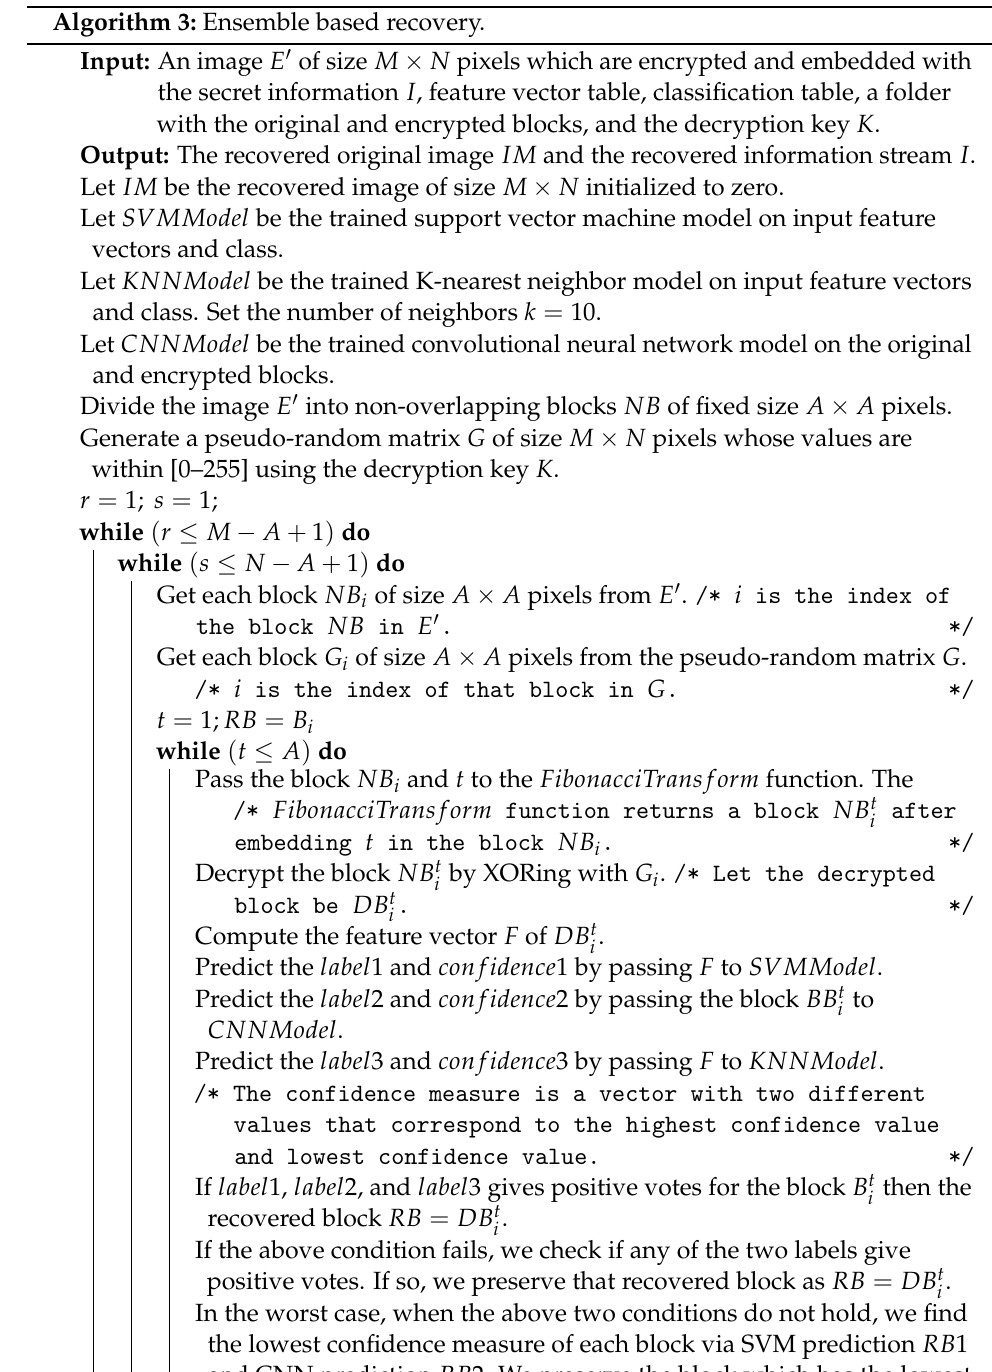
Algorithm 3: Ensemble based